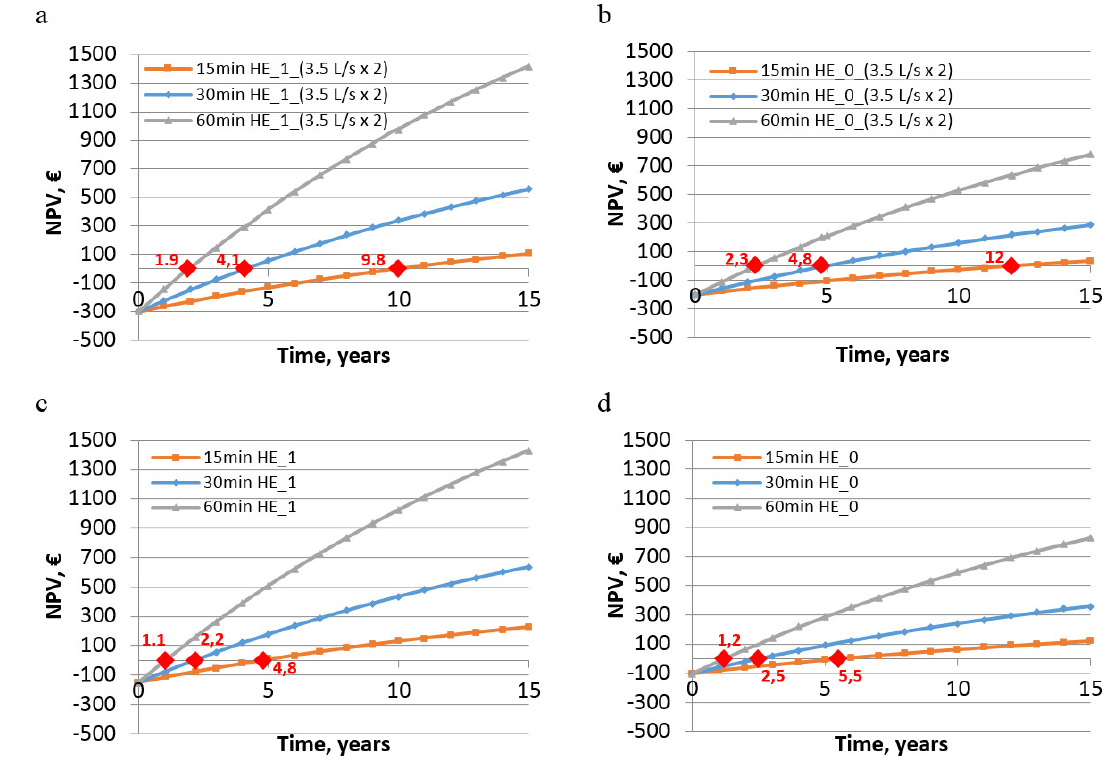
Figure 8. NPV values for Scenario A (365 days): ( a ) HE_1, Variant II; ( b ) HE_0, Variant II; ( c ) HE_1, Variant I; ( d ) HE_0, Variant I.